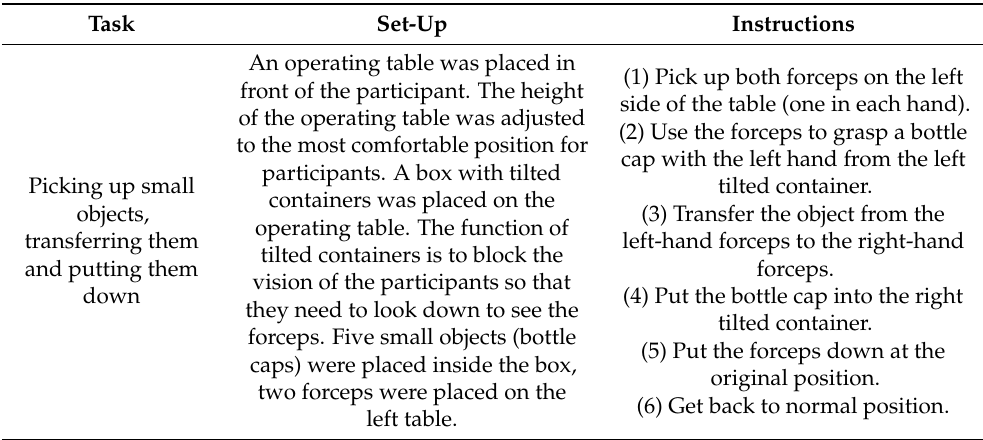
Table 1. Detail of simulated surgical